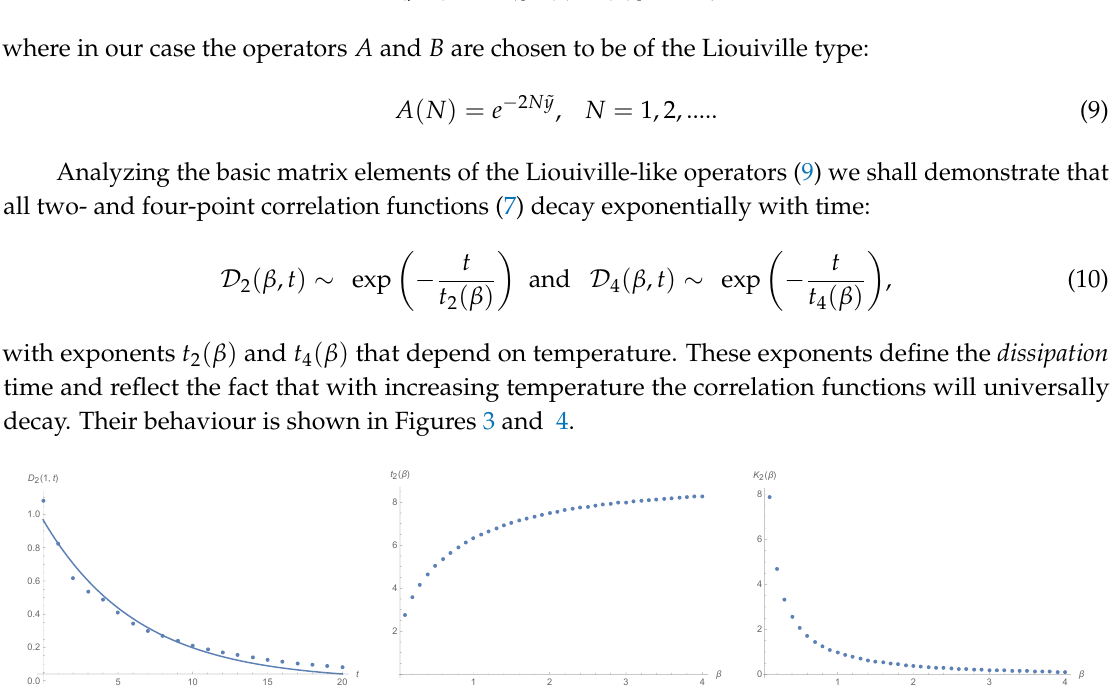
Figure 3. The exponential decay of the two-point correlation function D 2 ( β , t ) as a function of time at temperature β = 1. The points are fitted by the curve K 2 ( β ) exp ( − t / t 2 ( β )) . The exponent t 2 ( β ) has a well defined high and low temperature limits. The limiting values in dimensionless units are t 2 ( 0 ) ≈ 0.276 and t 2 ( ∞ ) ≈ 0.749. The temperature dependence of K 2 ( β ) is shown at the far